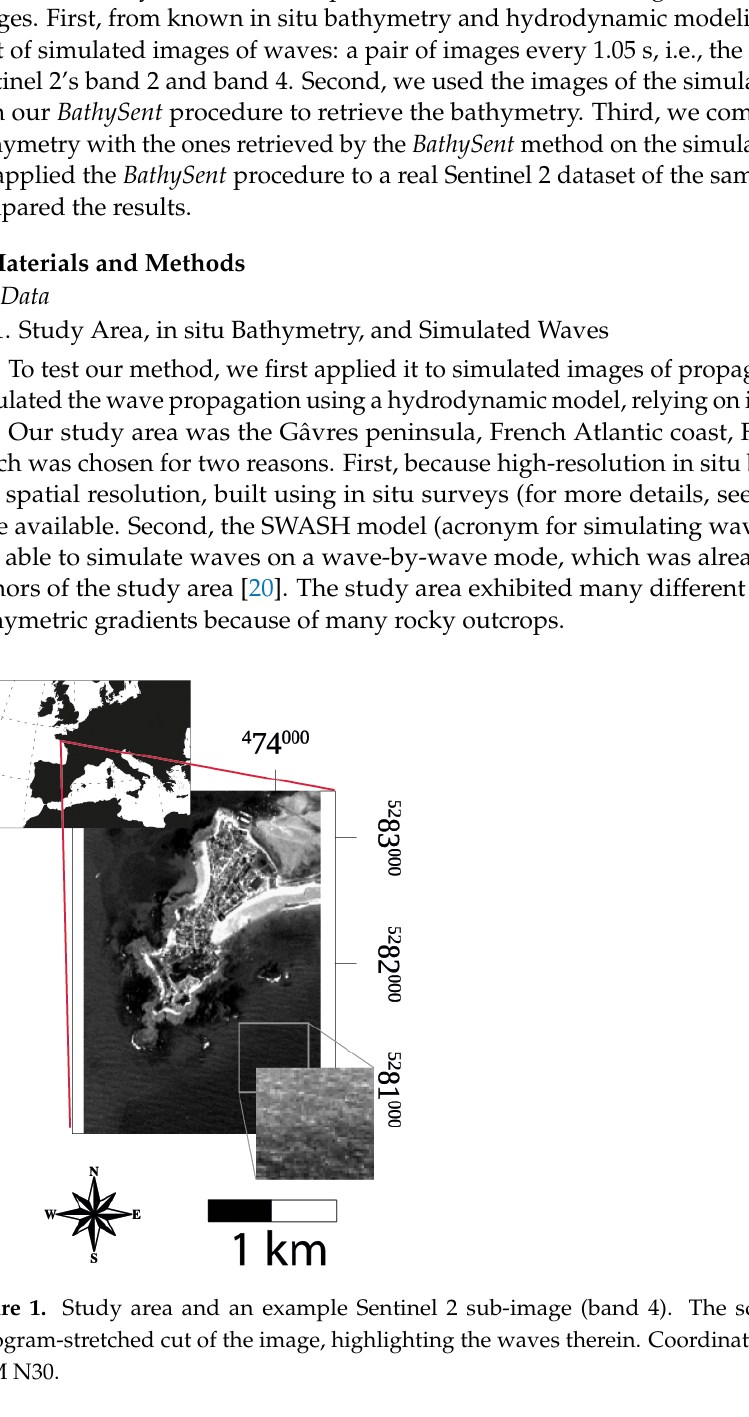
Figure 2. ( a ) In situ bathymetry. ( b , c ) two examples of simulated wave images, shaded from simu- lated waves height. The solar azimuth and zenith angles used for shading are standard values (45°, 45°). Coordinates are expressed in UTM N30. 2.1.2. Sentinel 2 MultiSpectral Imager